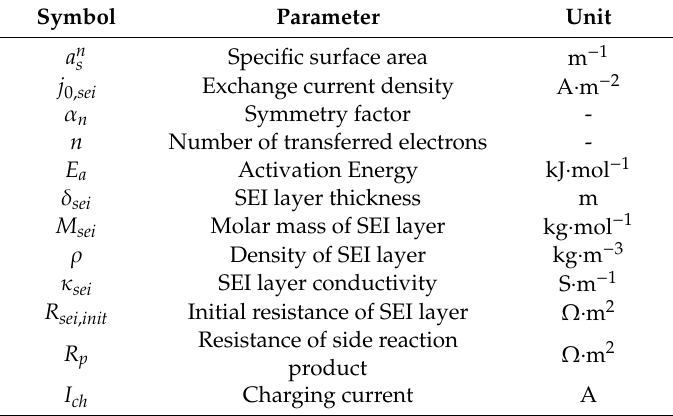
Table 2. Aging sub-model